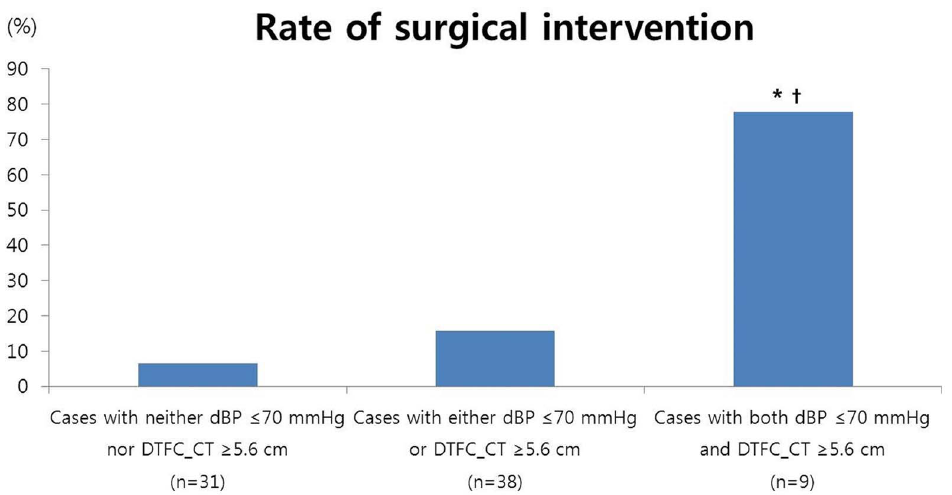
Figure 2. The rate of surgical intervention according to the absence or presence of risk factors. *, p , 0.05 compared to the cases with neither a dBP # 70 mmHg nor a DTFC_CT $ 5.6 cm; { , p , 0.05 compared to cases with either a dBP # 70 mmHg or a DTFC_CT $ 5.6 cm. The proportions were compared with Fisher’s exact test.